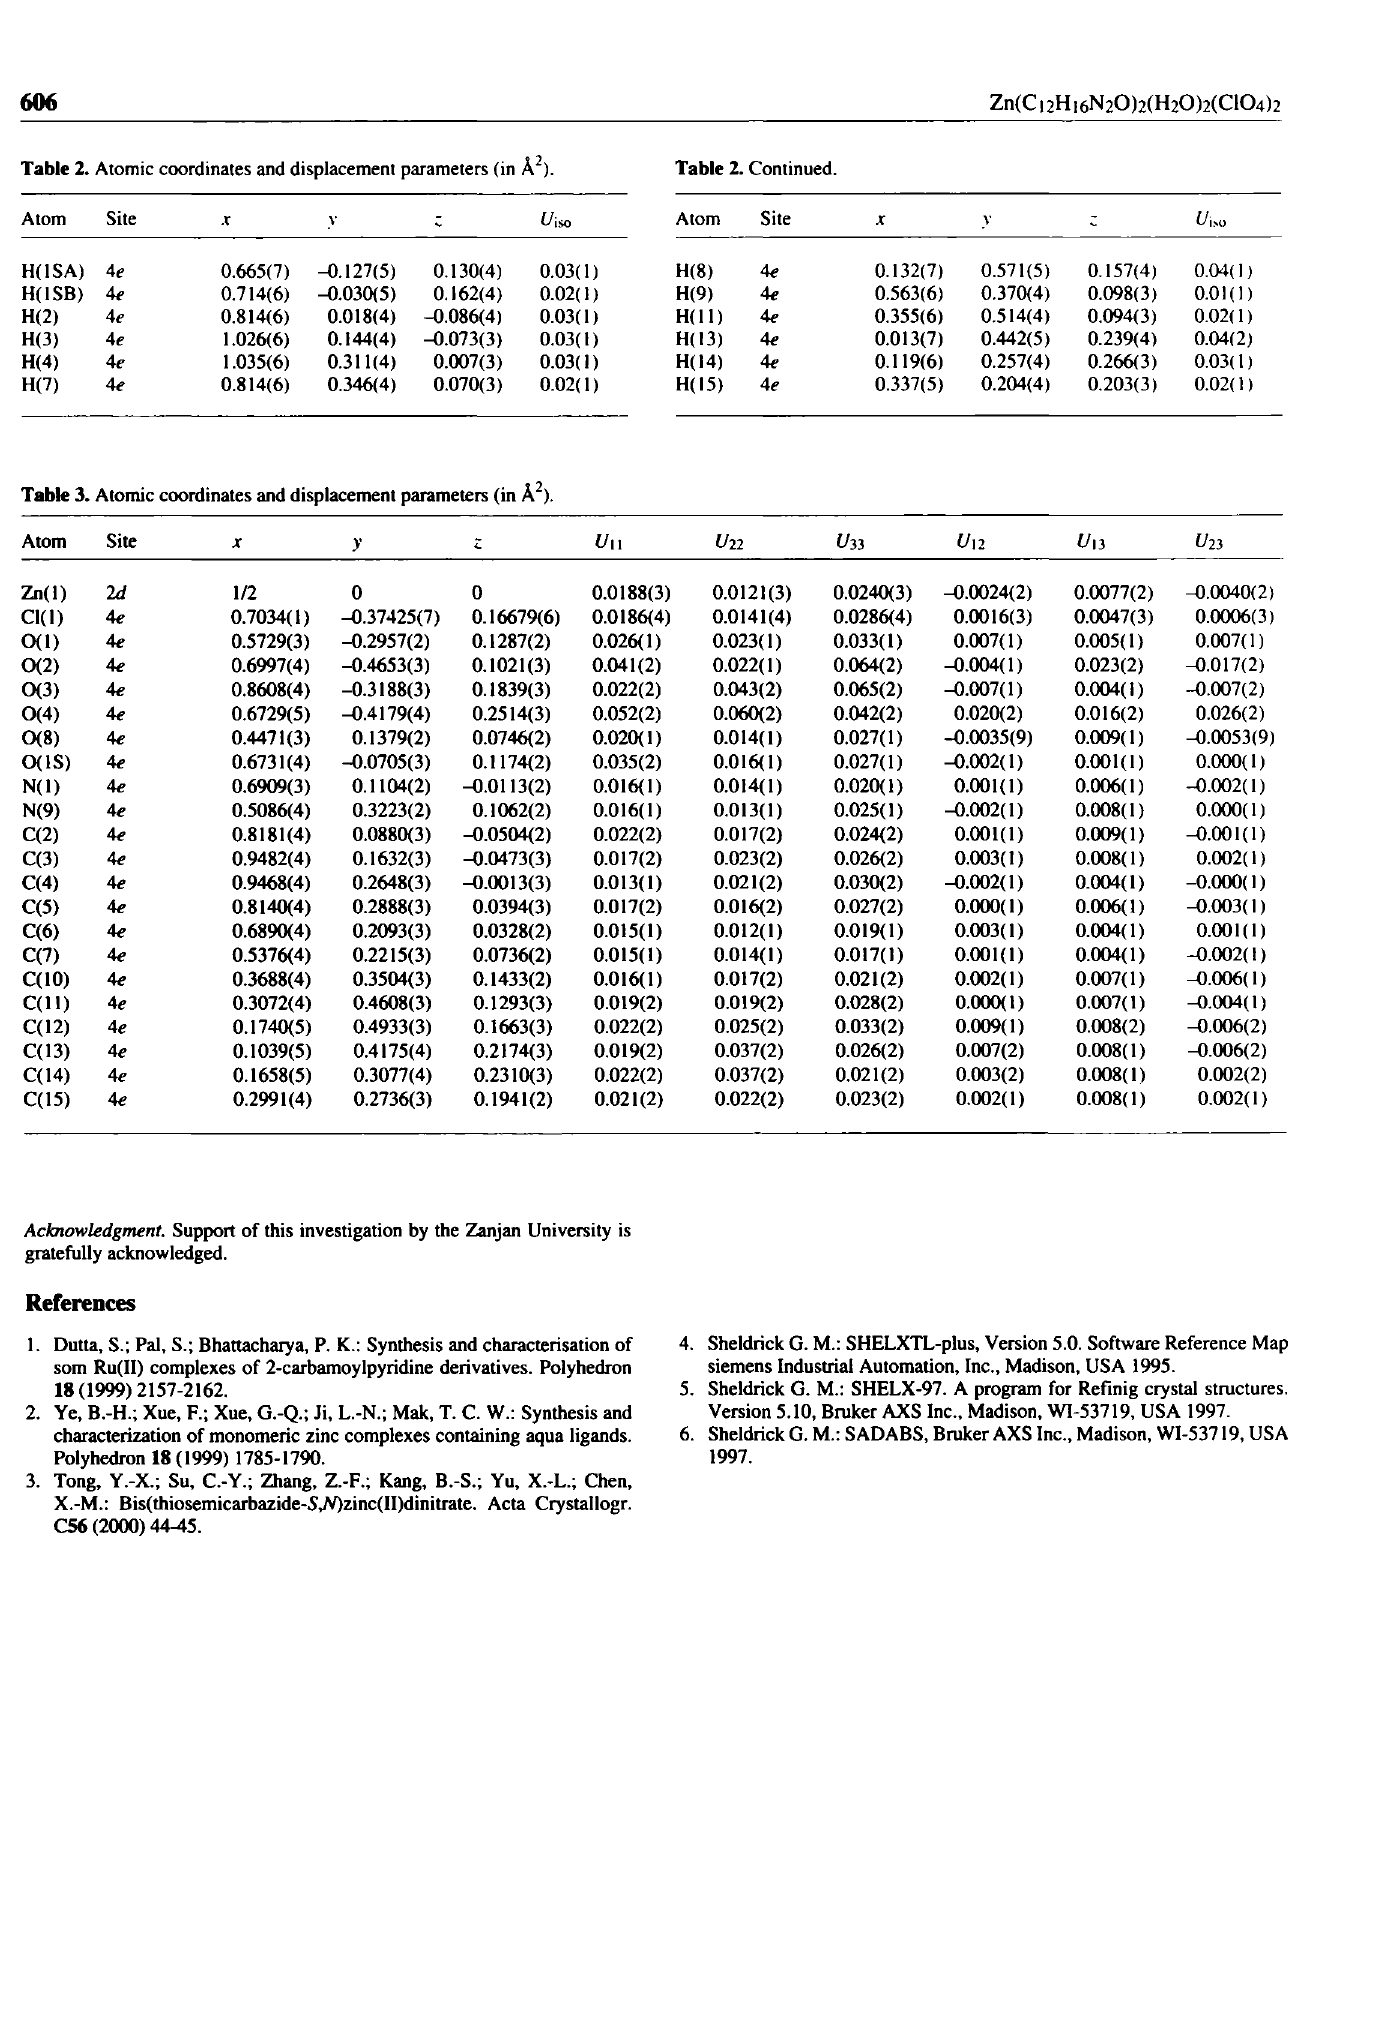
Table 2. Atomic coordinates and displacement parameters (in Ä 2 ). Atom Site